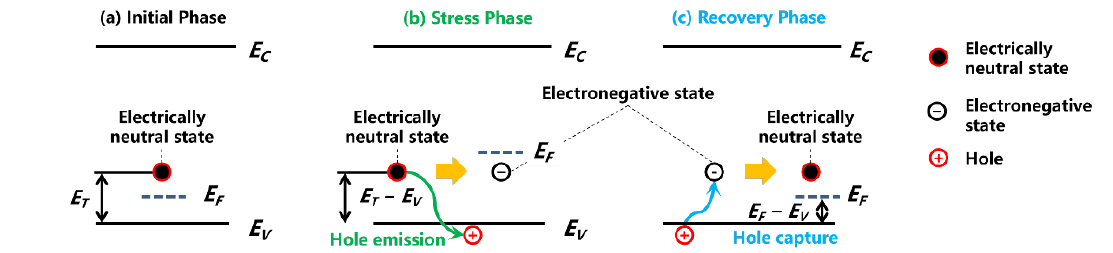
Figure 3. Schematic of acceptor-trap-induced capture and emission of free carriers.